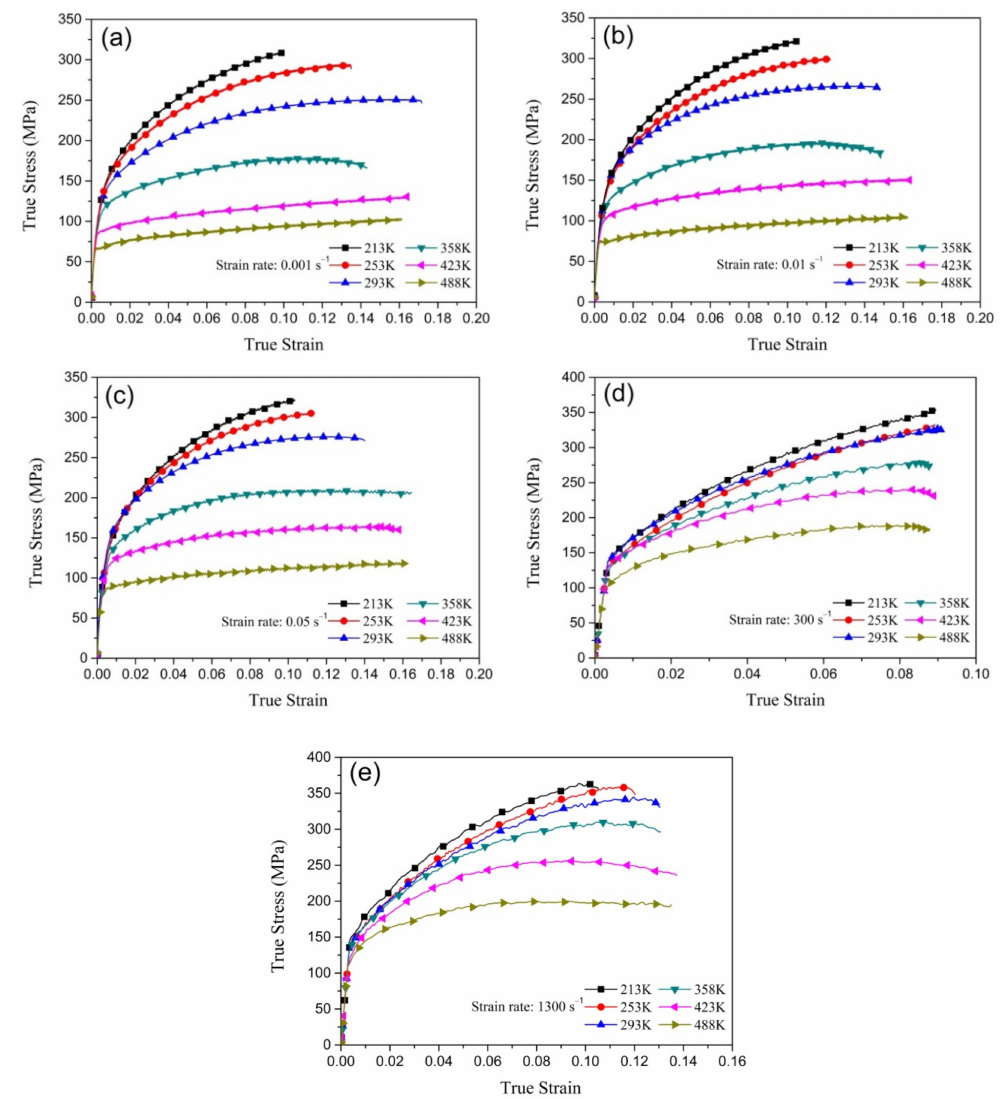
Figure 4. True stress-true strain responses at various temperatures and strain rates of ( a ) 0.001 s − 1 ,